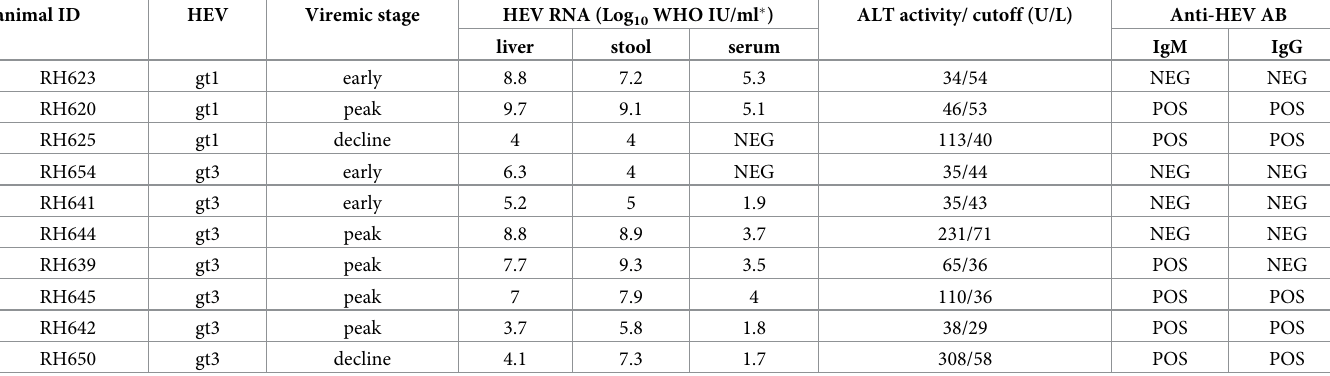
Table 1. Liver biopsy sample of the animals with primary HEV gt1/gt3 infection used for RNA sequencing. animal ID HEV Viremic